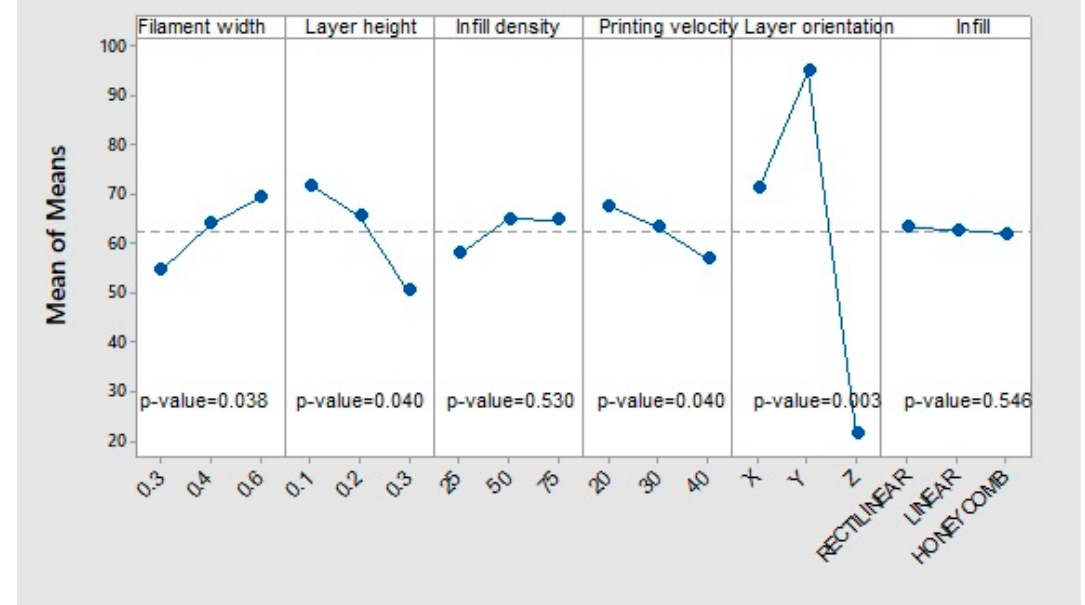
Figure 12. Main e ff ects of means for maximum Figure 12. Main effects of means for maximum strength.